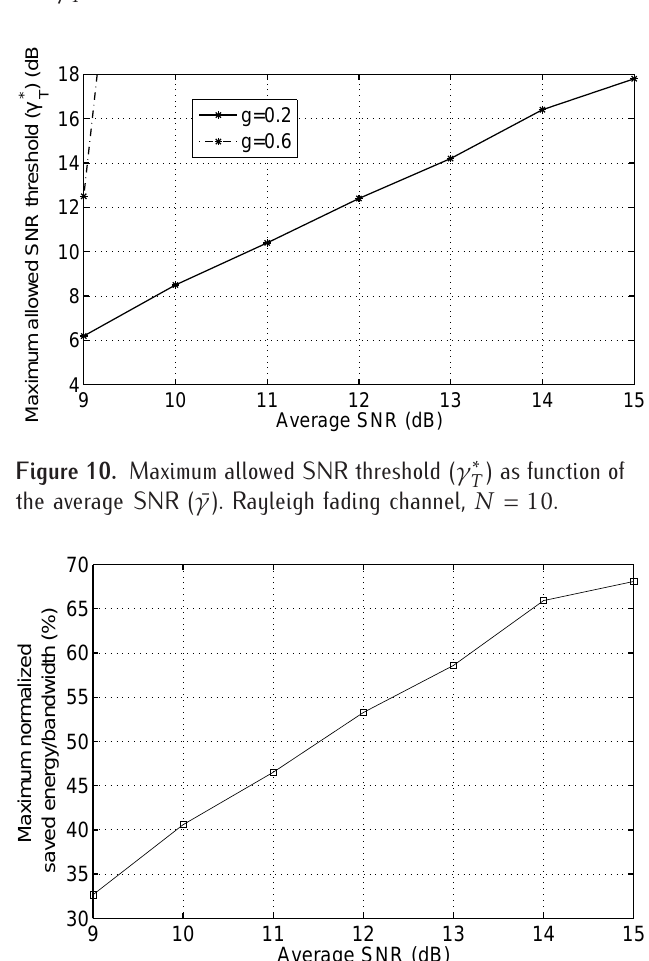
Figure 11. Maximum normalized saved energy/bandwidth as function of the average SNR ( ¯ γ ). Rayleigh fading channel, N = 10 , g = 0 . 2